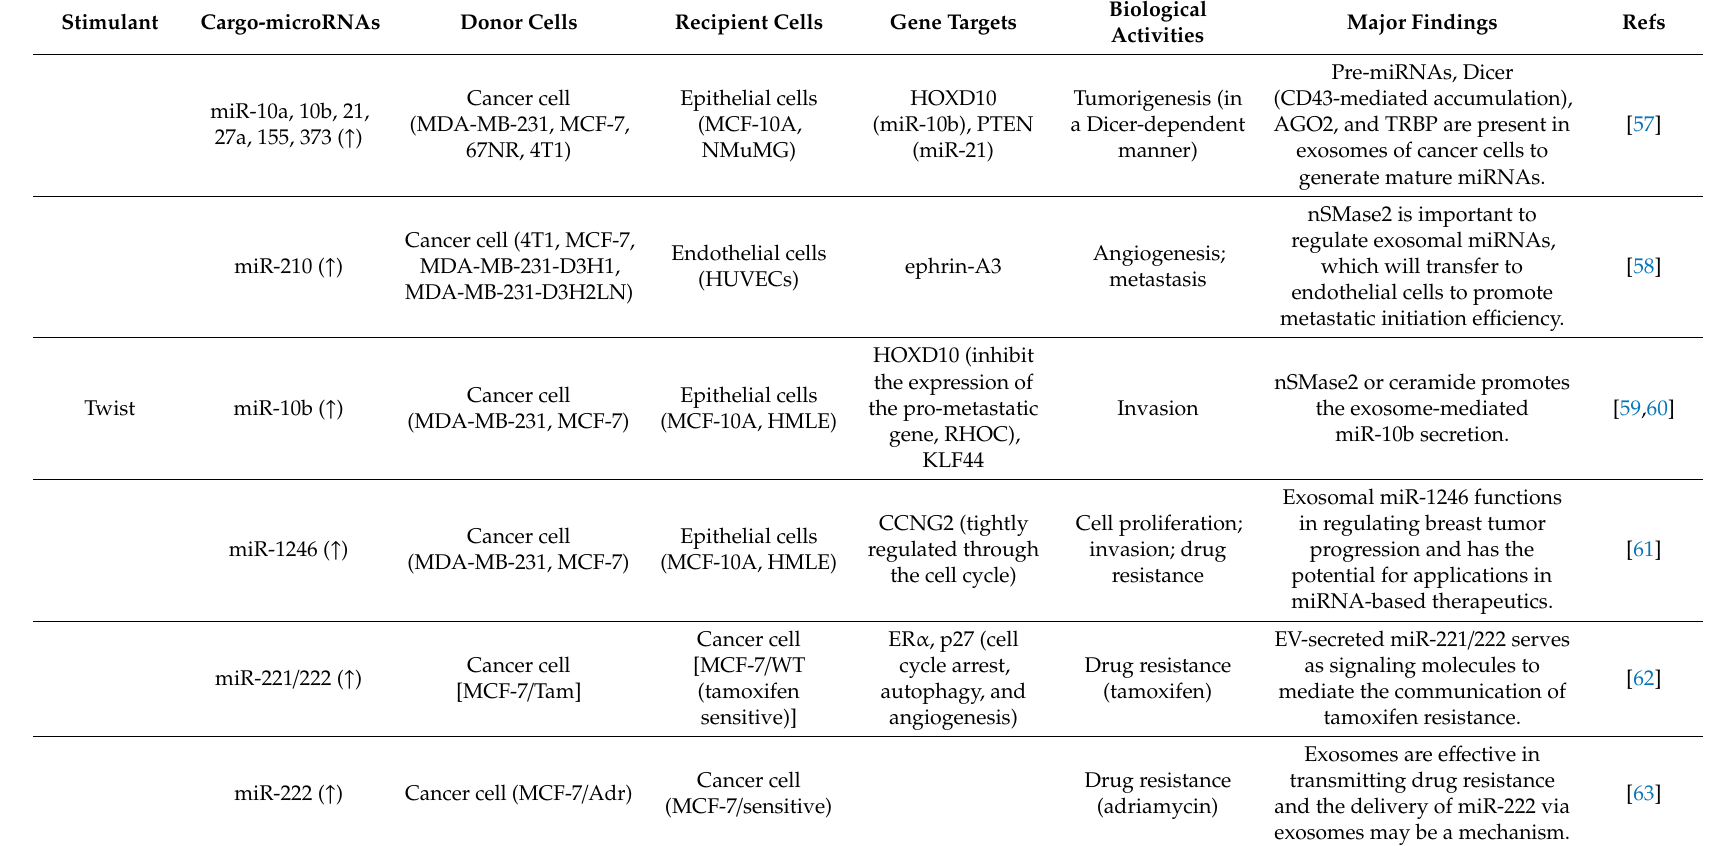
Table 2. Evidence supporting a role for exosomal microRNAs in cancer cell-cell communication (from cancer cells).